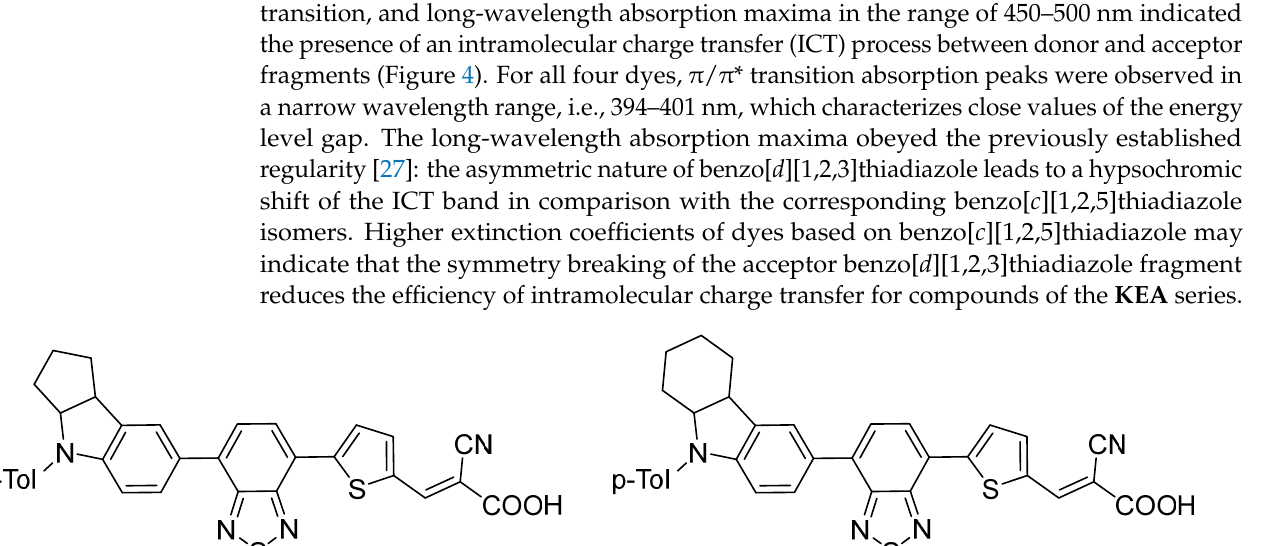
Figure 3. Structures of the dyes MAX114 and WS-2 .